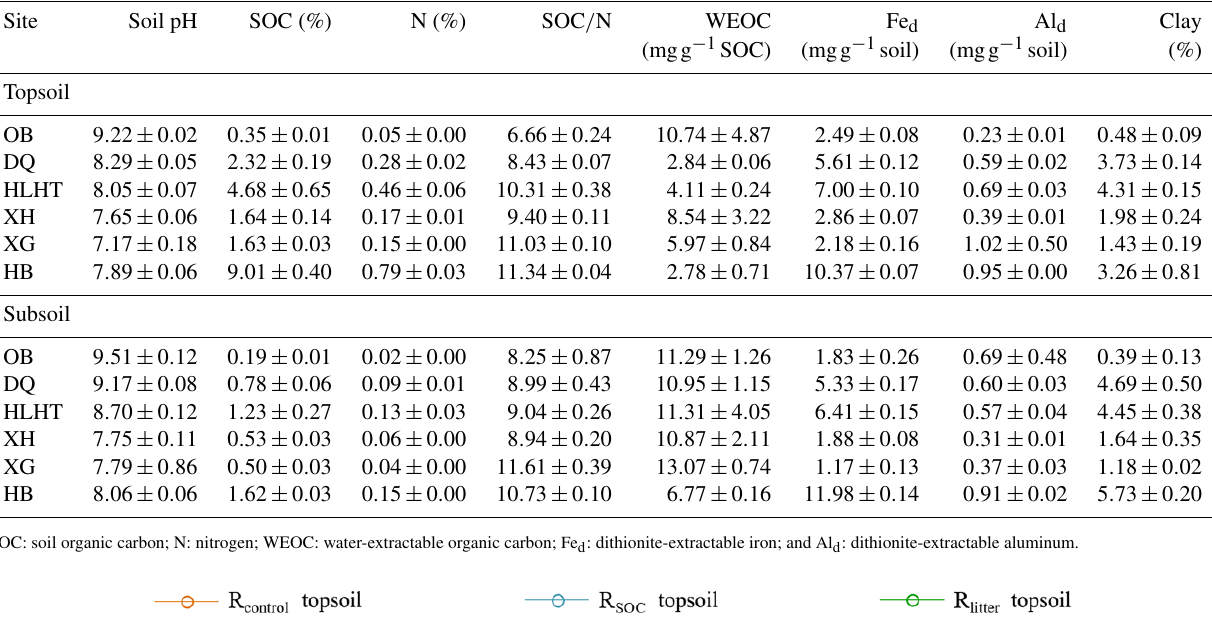
Table 2. Bulk properties of the studied soils (mean ± standard error; n = 3).